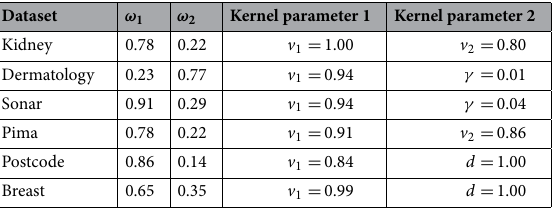
Table 2. The optimized result of the weight coefficients and kernel parameters.